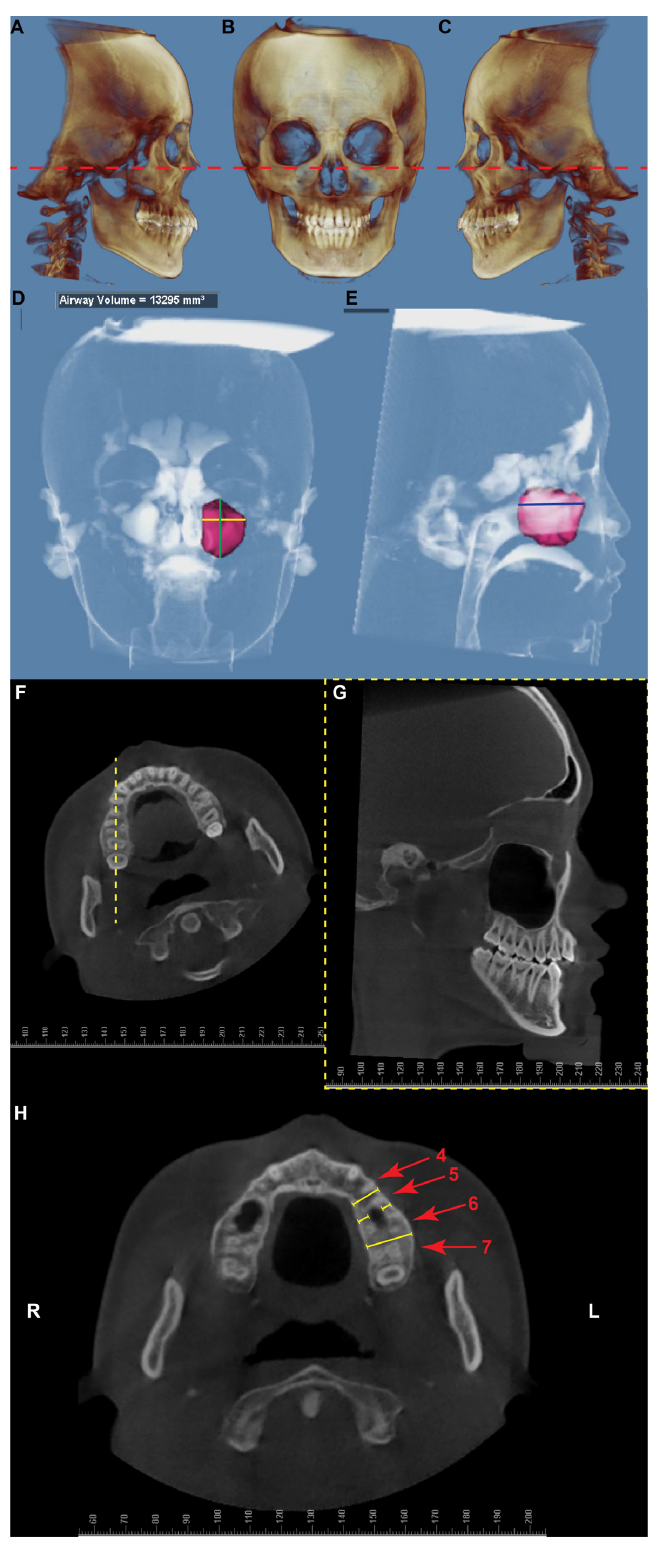
Figure 1. The demography of CBCT measurement protocol used in the current study. ( A – C ) The CBCT image was oriented to Frankfort horizontal plane (red dash line) using right and left